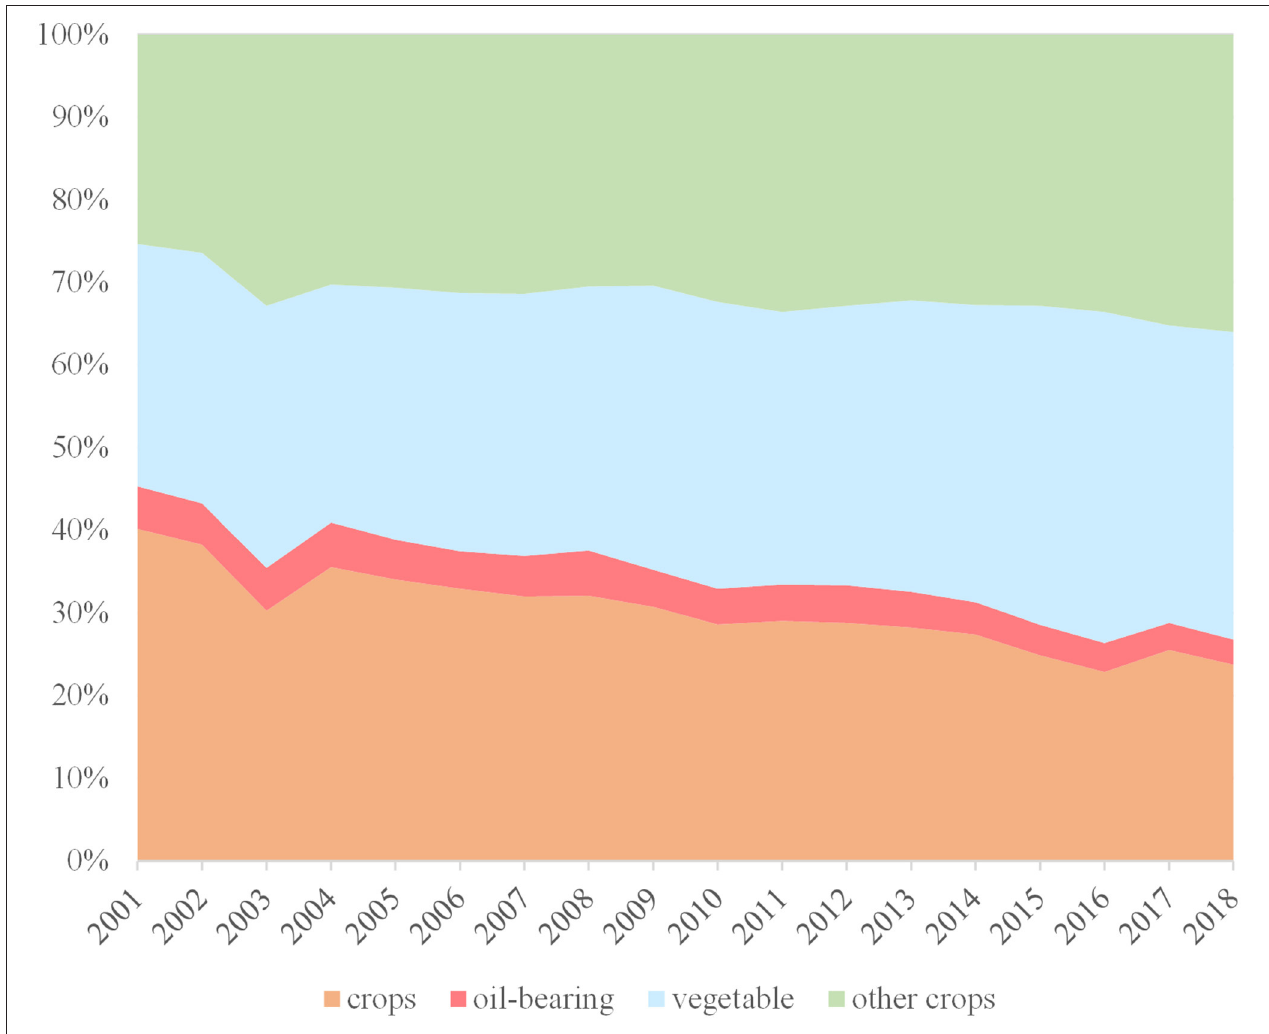
FIGURE 4 | Changes in the output structure of China’s crop industry